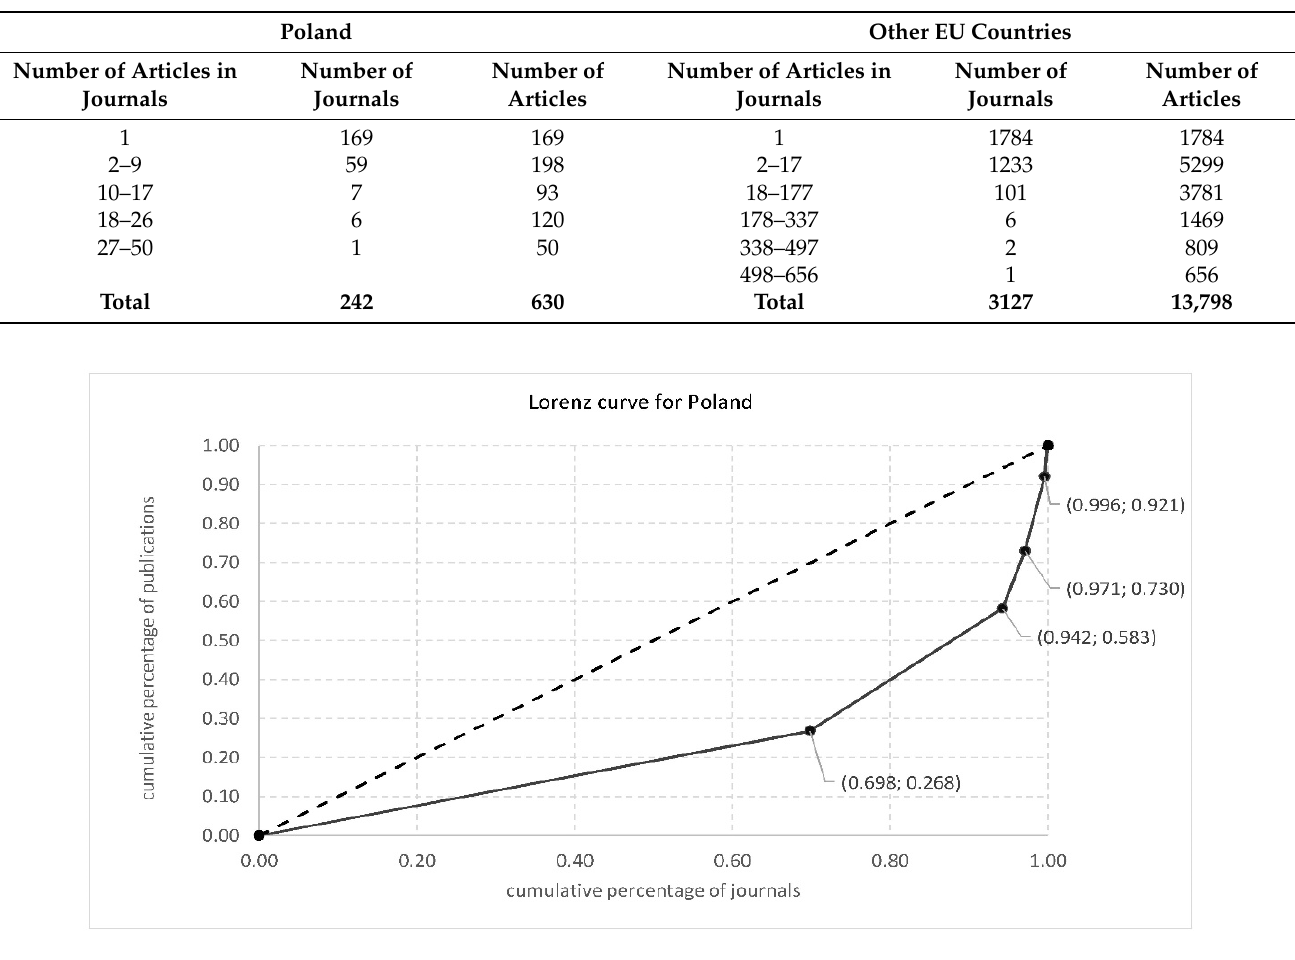
Table 5. Journal and article classification for the concentration analysis.